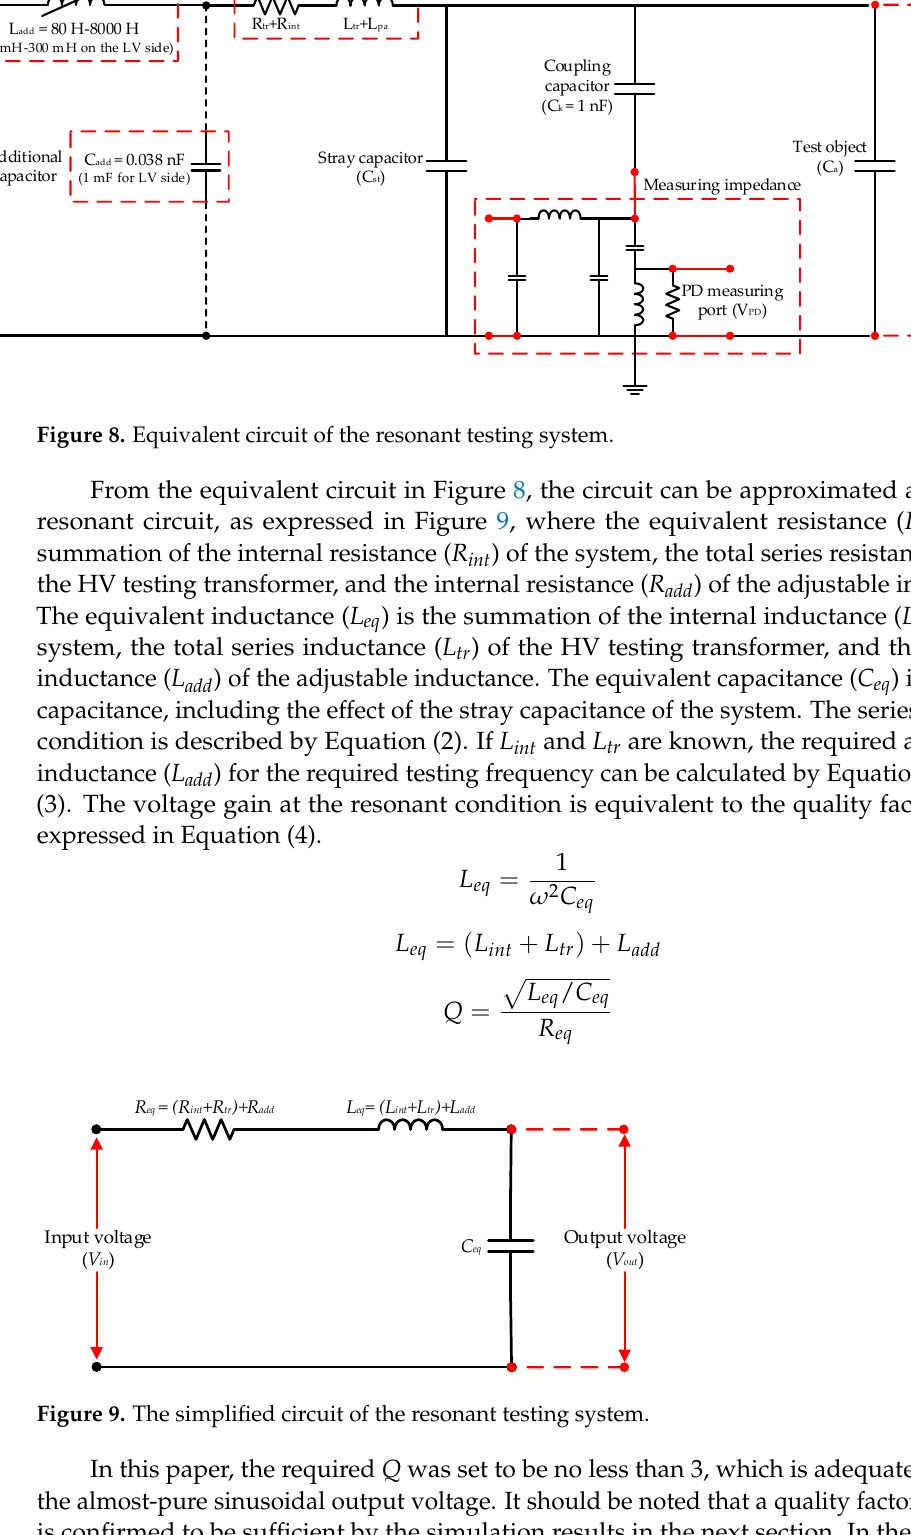
Figure 9. The simplified circuit of the resonant testing system.